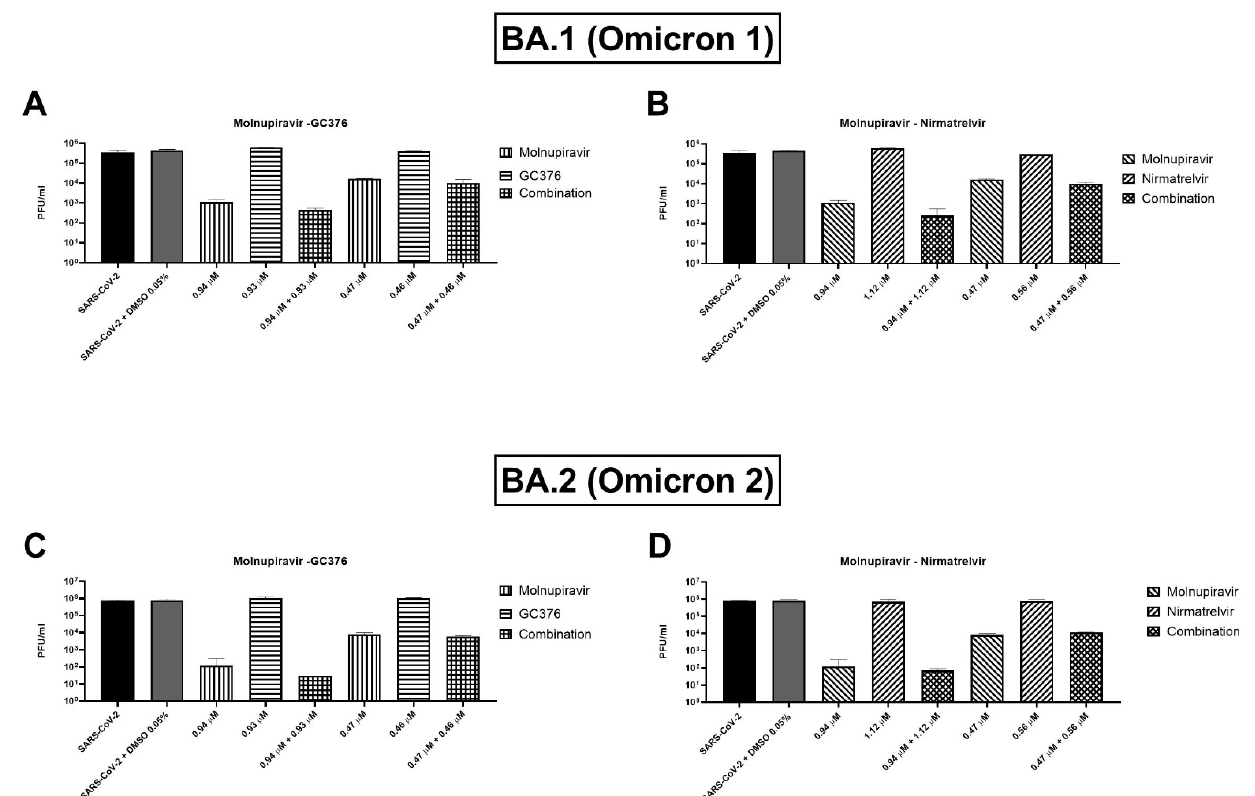
Figure 4. Plaque-reduction assay of the selected combination of antivirals. After synergy tests, supernatants of SARS-CoV-2 ( A , B ) BA.1 and ( C , D ) BA.2 infected Vero E6 cells treated with combinations of antivirals were frozen and selected concentrations of ( A , C ) molnupiravir–nirmatrelvir and ( B , D ) molnupiravir–GC376 were tested for viral load by plaque assay. Viral titers are expressed as mean ± SD of plaque-forming units (PFU)/mL from one experiment performed in triplicate.